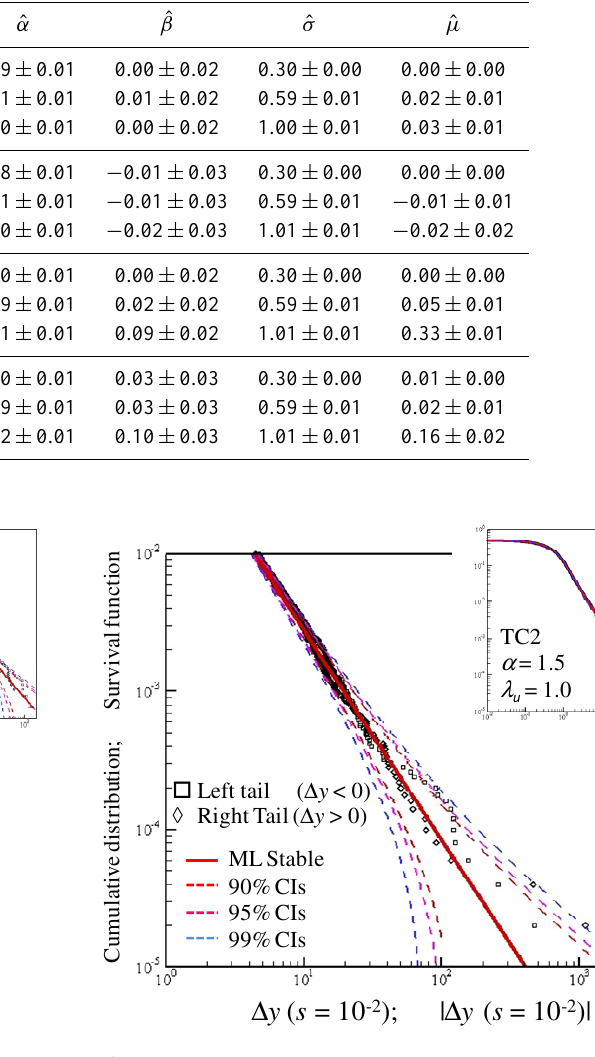
Fig. 3. Cumulative distribution versus | 1y | for 1y < 0 and survival function versus 1y for 1y > 0 of TC2 at s = 10 − 2 . Main figure emphasizes behaviour at tails. Solid curves represent ML fitted sta- ble distribution; dashed curves indicate confidence intervals, CIs.